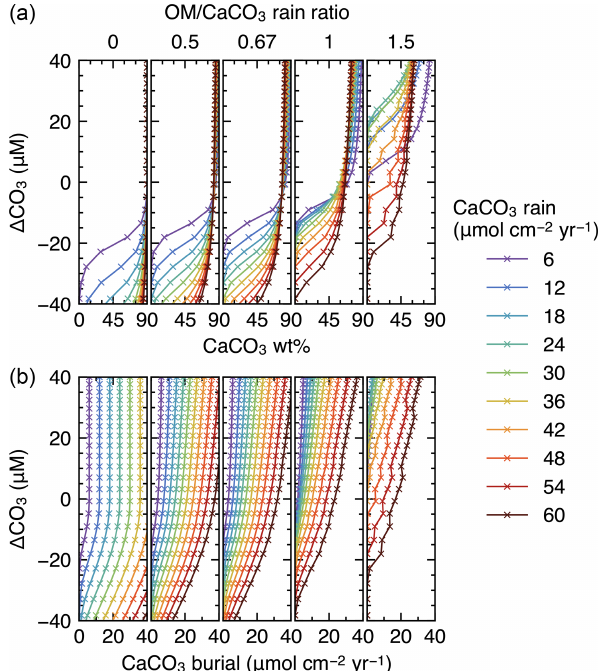
Figure 9. Same as Fig. 8 but enabling both oxic and anoxic degra- dation of organic